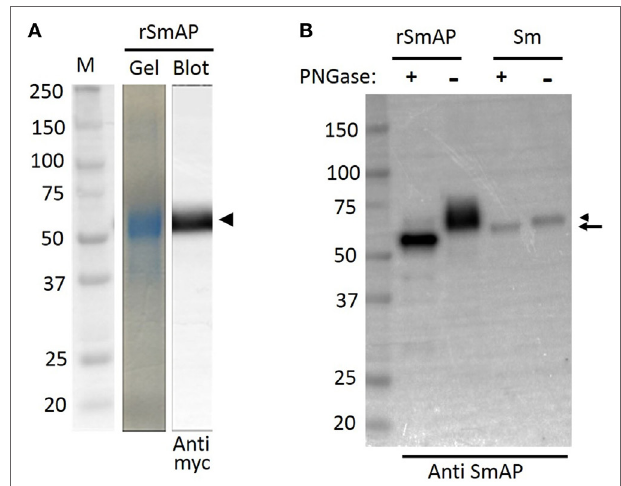
FigUre 1 | Analysis of Schistosoma mansoni alkaline phosphatase (SmAP) by SDS-PAGE and Western Blotting. (a) Following immobilized metal affinity chromatography, an aliquot of purified recombinant SmAP (rSmAP) was resolved by SDS-PAGE and the gel was stained with Coomassie Blue. A prominent band at ~60 kDa is seen (gel) that can also be detected by western blotting using an anti-myc tag antibody (blot), as indicated by the arrowhead. M indicates molecular size markers and the numbers given represent kDa. (B) Western blot analysis of SmAP glycosylation status. rSmAP or adult worm lysate (Sm) was resolved by SDS-PAGE following treatment with PNGase F ( + ) or after no treatment ( − ), as indicated. The native protein resolves as a prominent band at ~60 kDa (lane Sm − , right arrowhead). Following incubation of the worm extract with PNGase F, this larger band disappears and a slightly smaller band (at ~57 kDa) appears (lane Sm + , arrow). Incubation of rSmAP with PNGase F also leads to a notable shift in its migration profile; the broad band at ~60 kDa in the rSmAP “ − ” lane disappears and a band running at ~55 kDa is now seen (rSmAP + ). Numbers represent kDa of molecular size markers (left